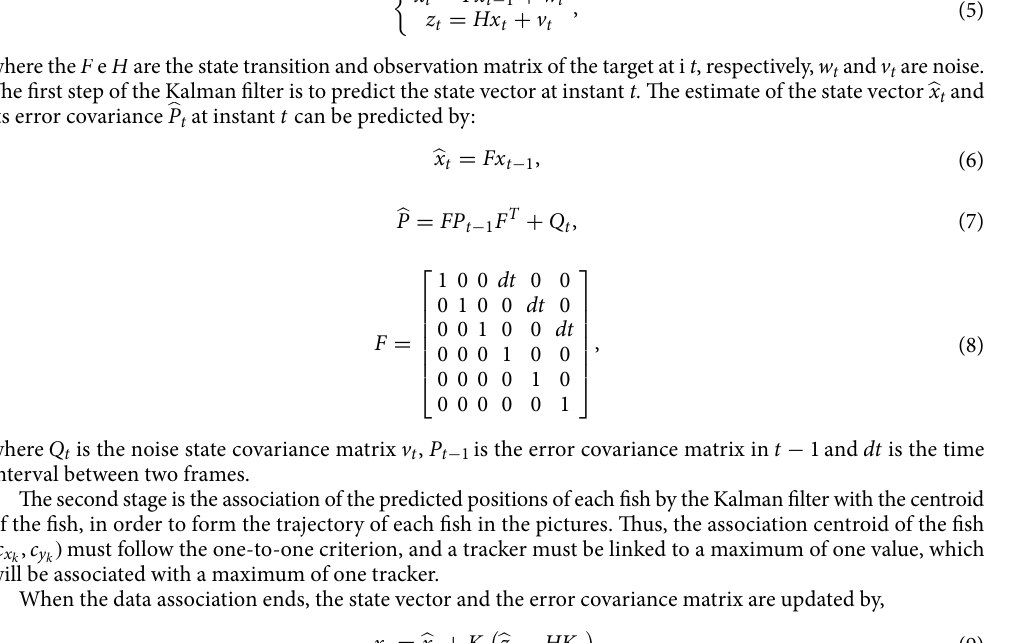
, p x ) is represented by the red dot. The direction of k k